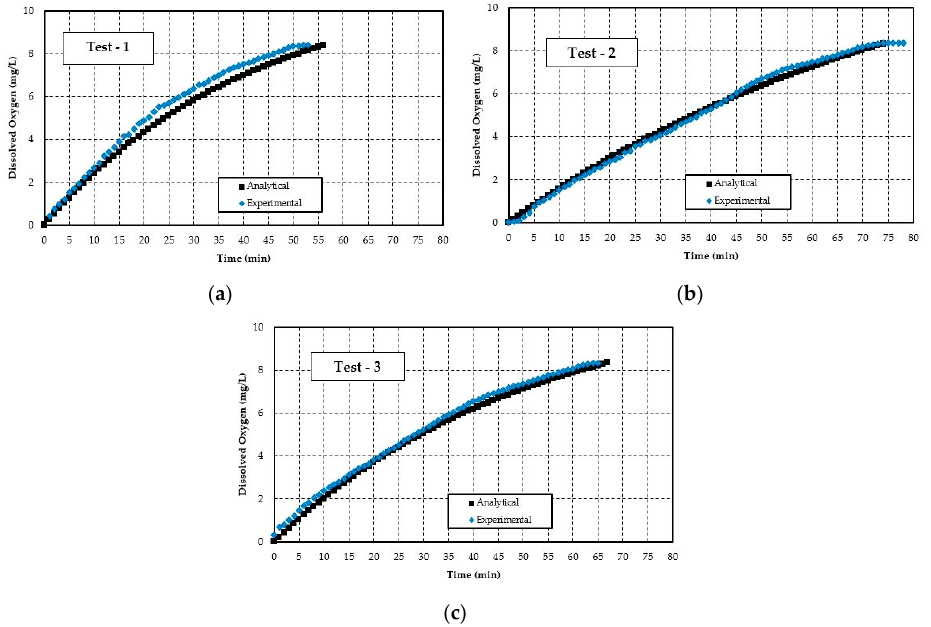
Figure 5. Dissolved Oxygen (mg/L) versus Time (min) for three test conditions defined in Table 2: ( a ) Test-1; ( b ) Test-2; ( c ) Test-3.